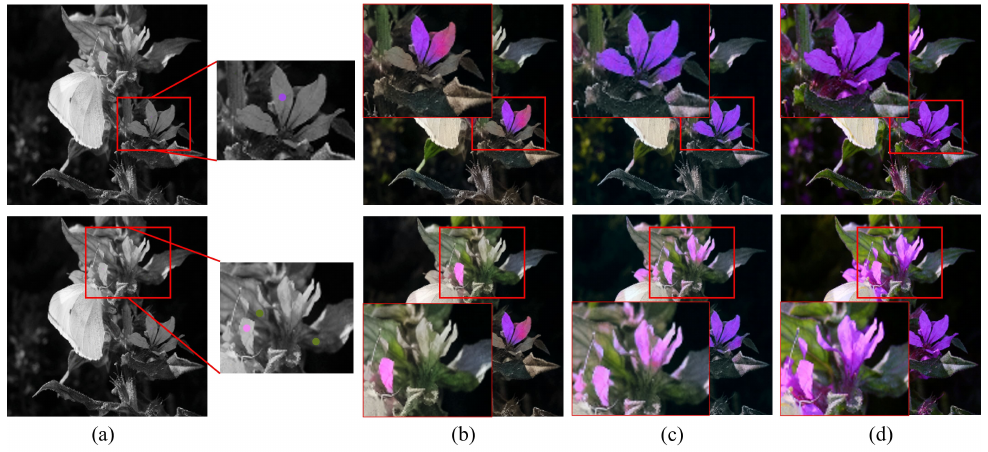
Figure 6. Comparison of hint-based colorization. ( a ) Input luminance and color hints. ( b ) Results of a CNN (Zhang’s method [7]). ( c ) Results of our transformer-based colorization. ( d ) Ground truth. Note that the transformer-based method outperforms the CNN-based method because it considers rich long-range dependencies. Color hints have been enlarged for visual